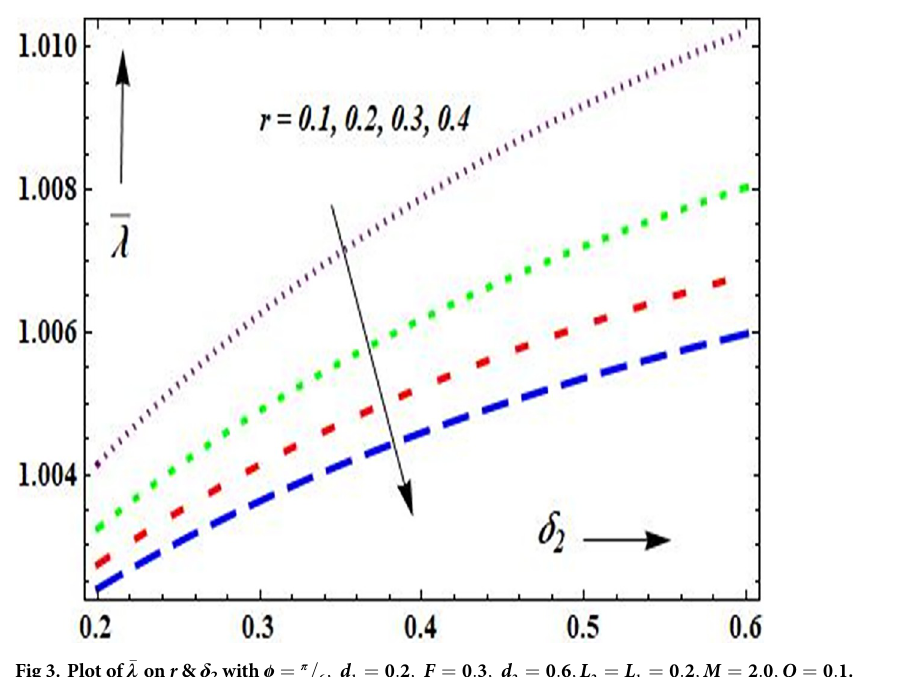
Fig 3. Plot of � λ on r & δ 2 with ϕ ¼ π ; d ¼ 0 : 2 ; F ¼ 0 : 3 ; d ¼ 0 : 6 ; L ¼ L ¼ 0 : 2 ; M ¼ 2 : 0 ; Q ¼ 0 : 1 = . 6 1 2 2 1 https://doi.org/10.1371/journal.pone.0266727.g003 (cid:0) � The stream resistance � l ascends for the tallness of the stricture ( δ ) and succumbs to a stature 1 of dilation ( δ ) like a point of inclination ( ϕ ) increments, as displayed in Figs 6 and 7. These dis- 2 coveries appear that there is a huge variation in a socket stream span in a slanted supply route, which impacts the stream because of the more modest lumen amount. When contrasting